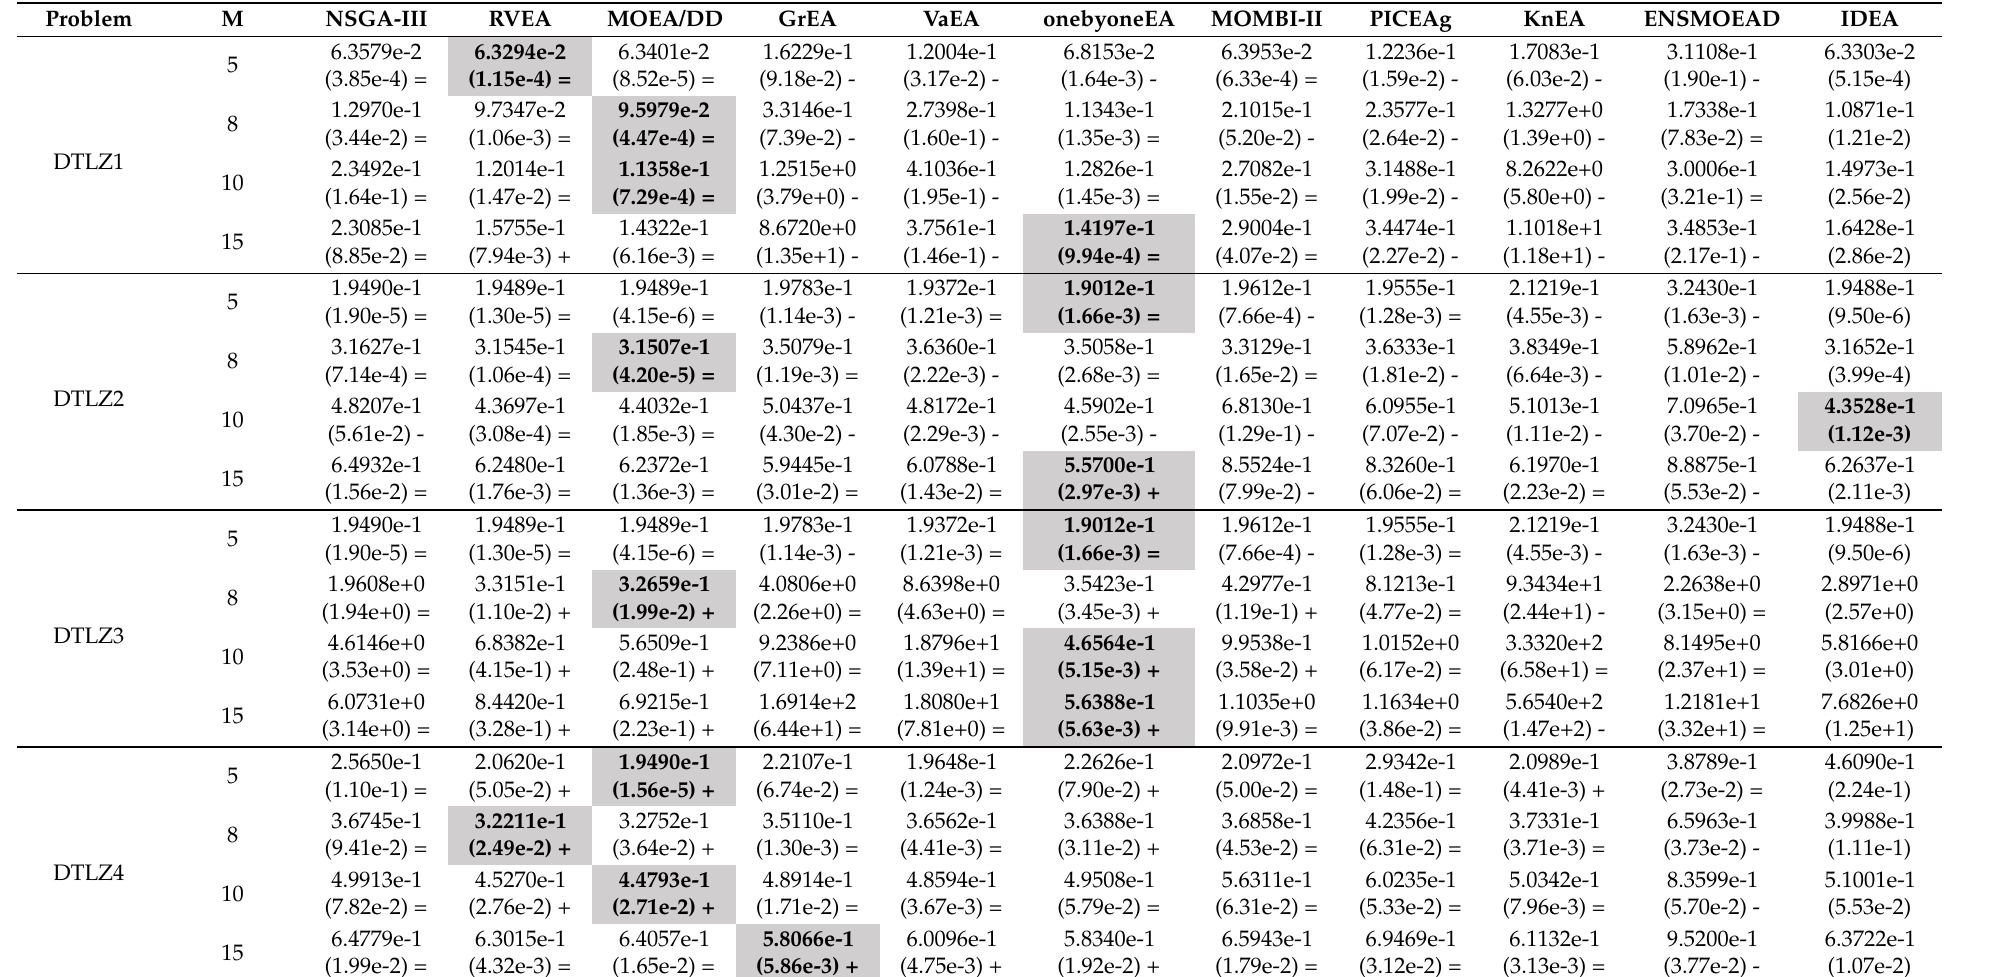
Table 3. The statistics of IGD results (mean and standard deviation) on regular Pareto front